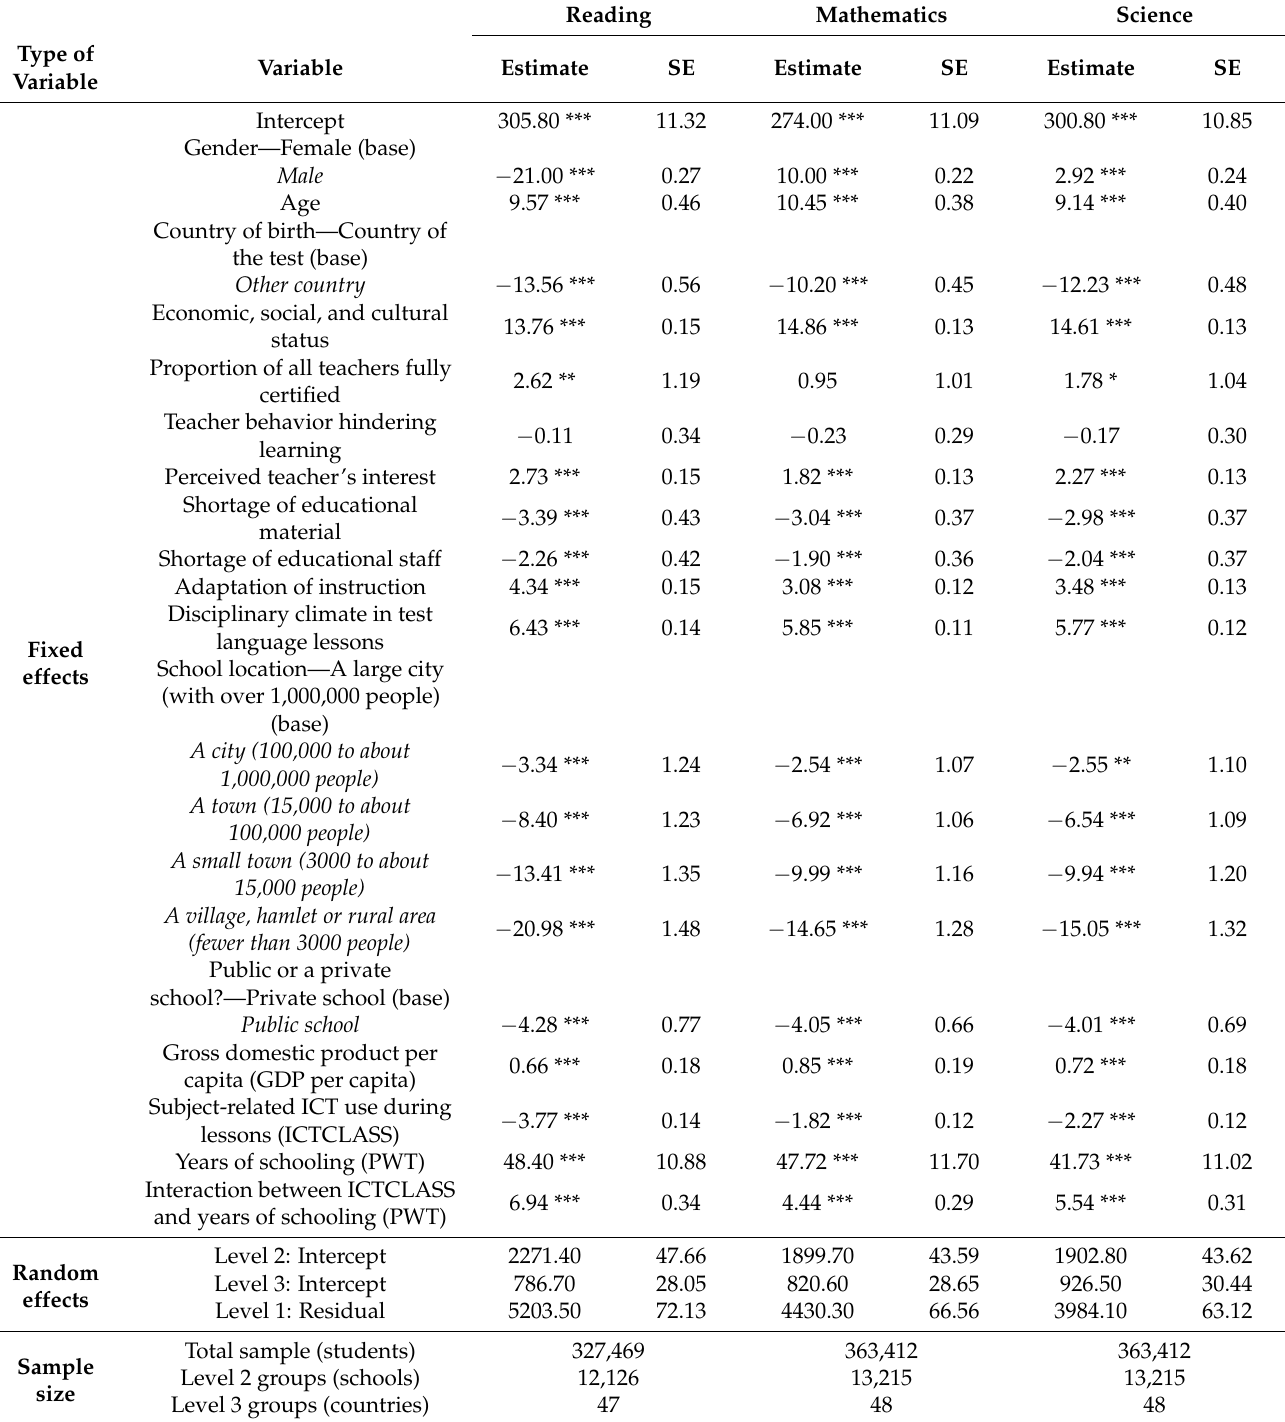
Table 4. HLM estimations predicting students’ outcomes and considering years of schooling (PWT) as indicator of the countries’ stock of human